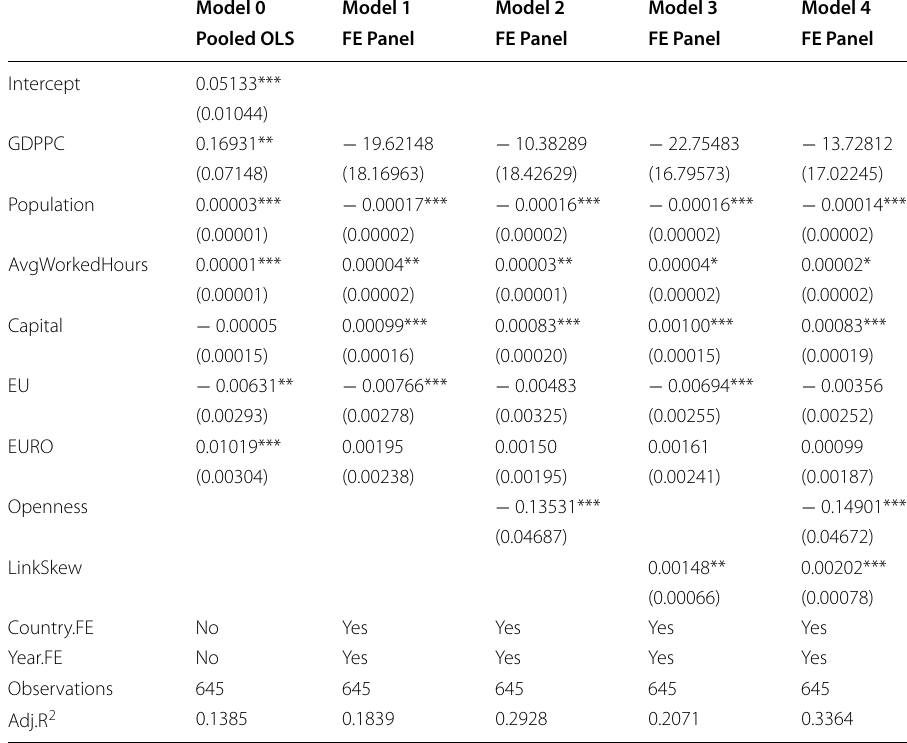
Table 3 The results of panel regression models